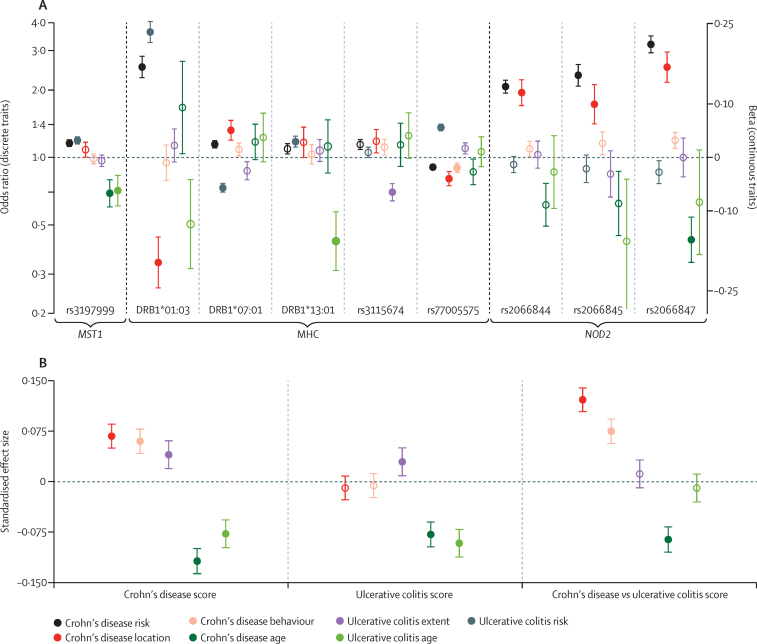
Effect of single nucleotide polymorphisms, HLA alleles, and polygenic risk scores on phenotypes of inflammatory bowel disease(A) Effect sizes for genotype–phenotype associations for risk of Crohn's disease and ulcerative colitis (odds ratio relative to controls), Crohn's disease location (odds ratio of ileal vs colonic disease), Crohn's disease behaviour (proportional odds ratio), disease extent of ulcerative colitis (odds ratio of extensive vs non-extensive disease), and age at diagnosis (linear coefficients) for MST1, MHC, and NOD2 variants. All effect sizes are per allele, and are adjusted for associations with correlated phenotypes by including them as additional predictors in the regression model, along with principal components to control for stratification. See appendix A for more details on these regression models. Genome-wide significant associations are depicted by filled circles, and error bars depict 95% CIs. (B) Effect sizes of genetic risk scores for disease location, disease behaviour, and age at diagnosis including all 163 susceptibility loci. Effect sizes are calculated by linear regression of the risk score against the phenotype, adjusted for the effect of the other phenotypes and for principal components, and error bars depict 95% CIs. Filled circles represent effects that are significant after correcting for 15 phenotype-score combinations (p<0·003). Effect sizes are measured on scales standardised to unit variance (and thus represent the number of standard deviations that the mean phenotype increases by per standard deviation increase in the risk score).